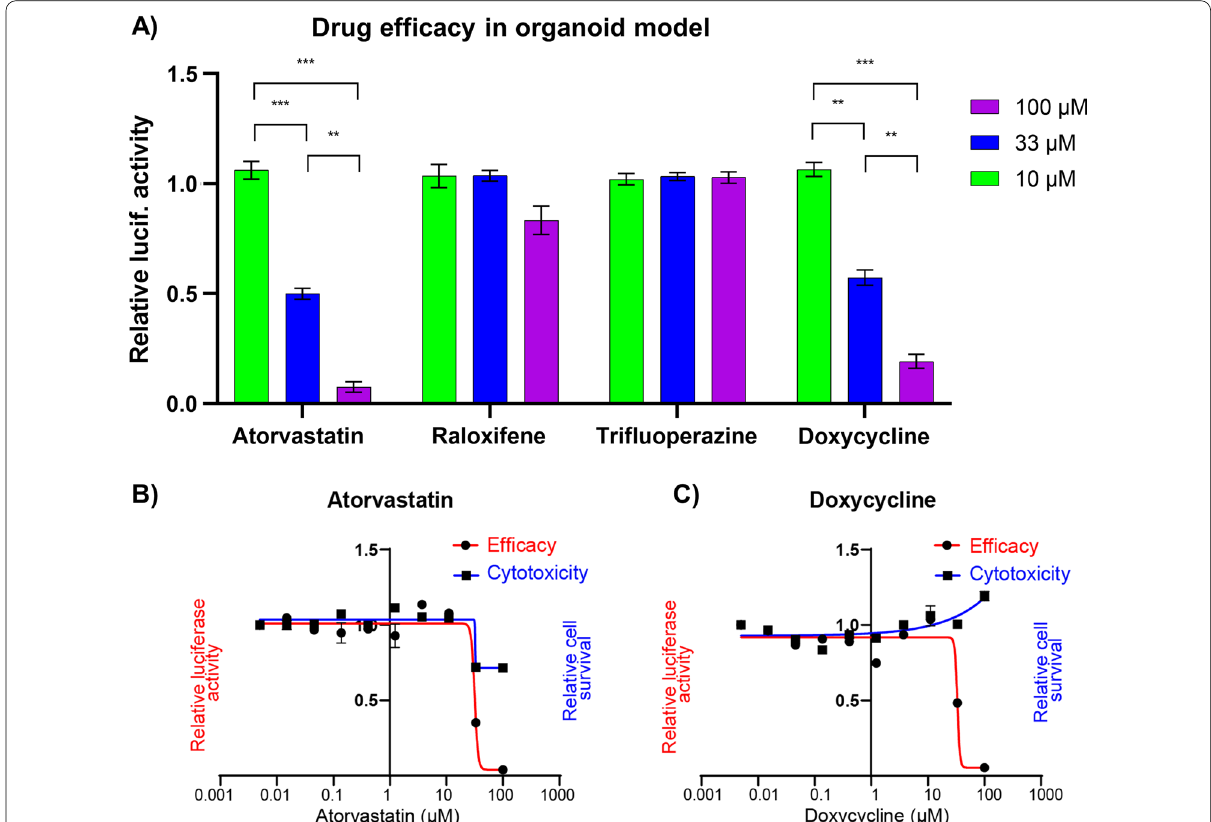
Fig. 3 The dose-dependent drug screening of three drugs whose transcriptional profiles correlate negatively with the host transcriptional signature associated with SARS-CoV-2 infection in the connectivity mapping analysis, which were further selected based on their predicted ability to bind to SARS-CoV-2 Mpro and RdRp. A Atorvastatin was the only drug that showed a dose-dependent reduction in viral entry in the SARS-CoV-2 lung organoid model, alongside our positive control (doxycycline). The bar plot shows the relative luciferase activity of multiple candidate drugs at 100 μM, 33 μM and 10 μM. The data was normalized to DMSO treated control. Data is presented as mean SEM. Two-way ANOVA, **P < 0.01, ± ***P < 0.001. B The dose-dependent efficacy curves of atorvastatin, and C doxycycline, suggest that these drugs inhibit viral entry in the SARS-CoV-2 lung organoid model. Their maximum half cytotoxicity concentrations are above the tested range. The data was normalized to DMSO-treated control. Data is presented as mean ±